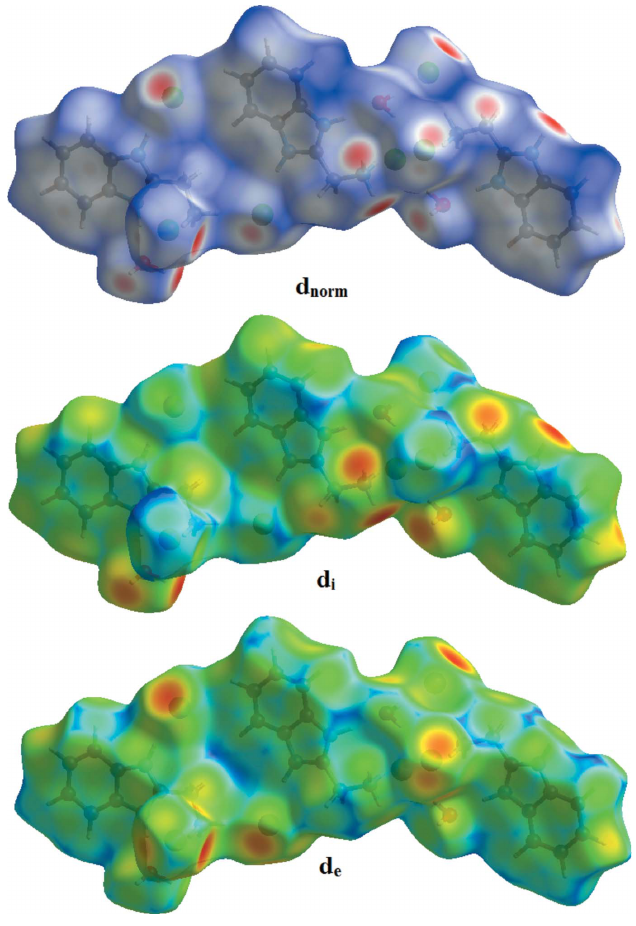
Figure 3 The Hirshfeld surface of the title compound mapped over d norm , d i and d e .